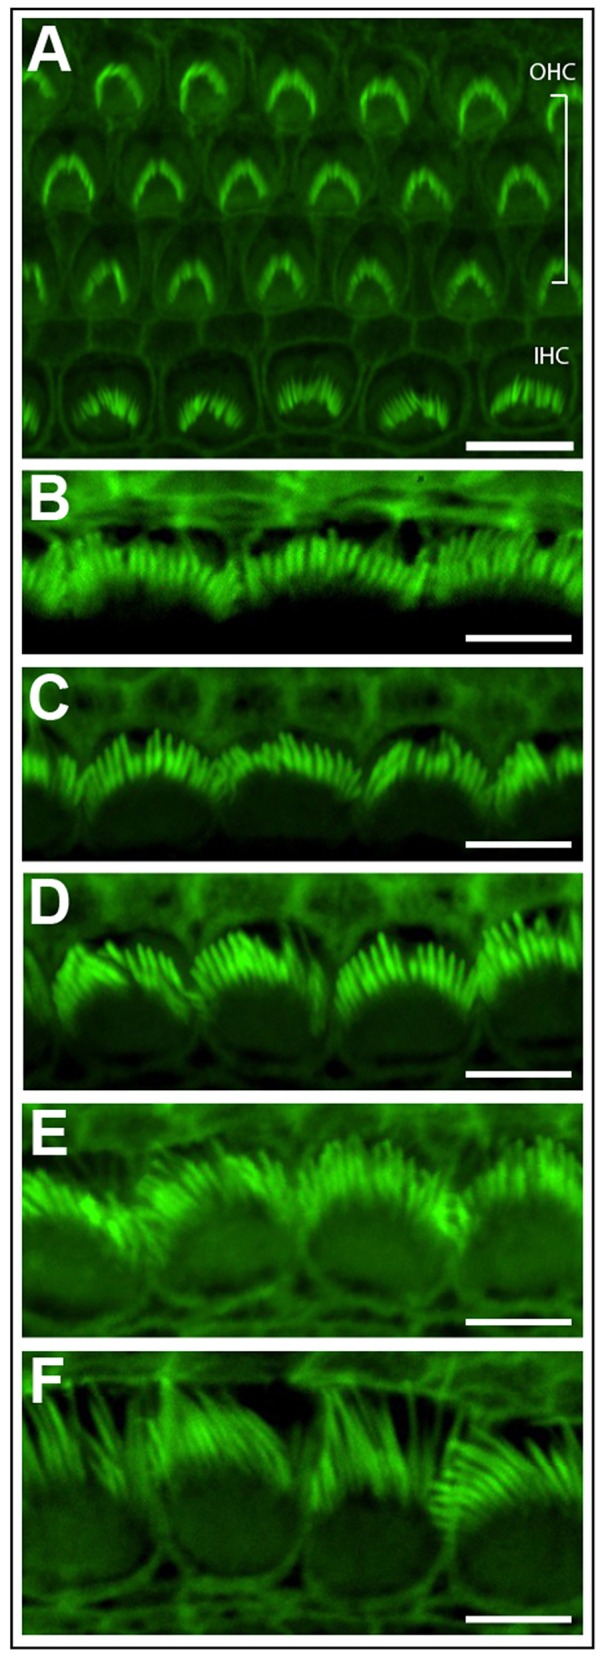
Phalloidin stained cochlear hair cells. (A) One row of inner hair cells (IHC) and three rows of outer hair cells (OHC) illustrating normal polarity and patterning of cochlear stereocilia bundles. Scale bar = 10 μm. (B–F) The length of inner hair cell stereocilia (green) increases from the basal to apical regions of the cochlea. Conversely, stereocilia width decreases from the cochlear base to apex. Images were progressively collected from the basal region of the explant (B) through to the mid-section (D) through to the apex (F) to demonstrate the graded change in stereocilia length and width. Scale bar = 5 μm. Tissues mounted using Prolong Diamond anti-fade reagent and coverslip #1.5.